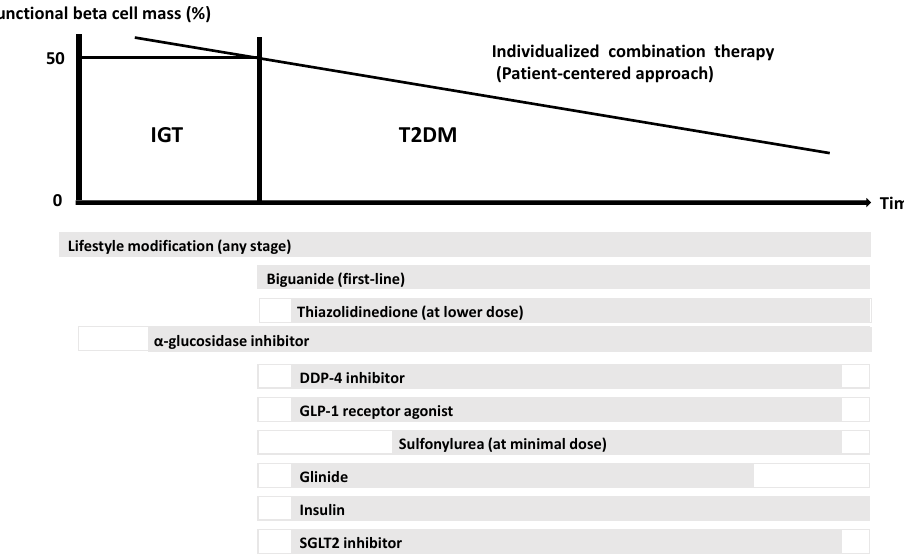
Figure 2. Proposed concept of treatment strategy for type 2 diabetes (T2DM) in Asians in relation to functional beta cell mass. An α -glucosidase inhibitor is partly approved for use in patients with impaired glucose tolerance (IGT) in Japan. Medications not approved in Japan are not included in the figure. Adapted and modified from references 4 and 45 [4,45].